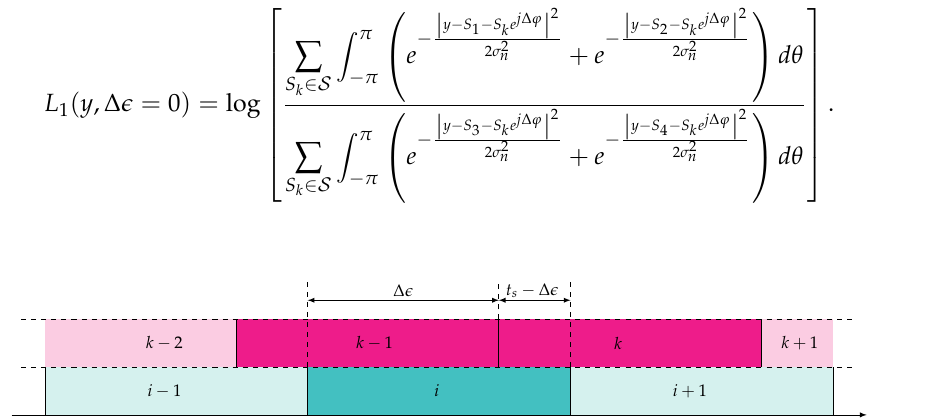
Figure 3. The i th codeword symbol (azure) affected by a single interferer (red), with a relative epoch of ∆ (cid:101) . Both interferer symbols k 1 and k impact the codeword symbol i . −